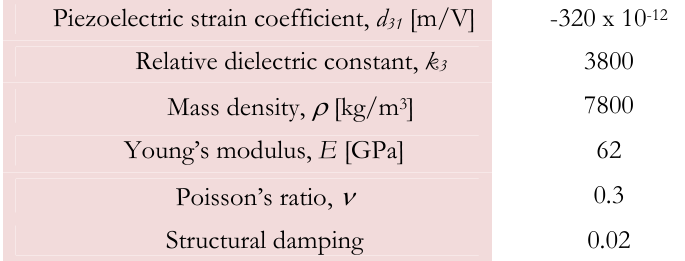
Table 1: Electrical and mechanical properties of